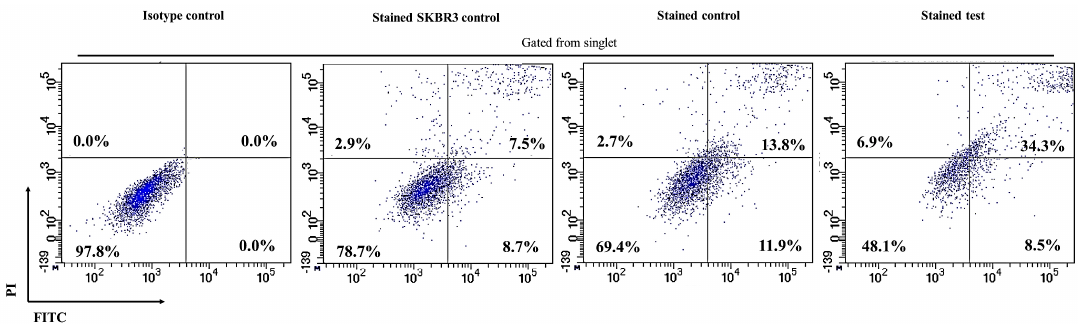
Figure 6. Detection of efficiency of CAR-T cells in SKBR3 cell lysis by FITC Annexin V Apoptosis Detection Kit. The FITC Annexin V Apoptosis Detection Kit was used to measure the amount of apoptosis seen in SKBR3 cells following co-culture with CAR-T cells (stained test) and non-transduced T-cells (stained control). SKBR3 single culture (stained SKBR3 control) was designated as the background. The cell population was gated at SKBR3 cells. Singlet was gated from the SKBR3 cells population to remove residual cell clumps following disaggregation and eliminate auto-fluorescence. Subsequently, apoptotic cells were gated from the singlet population. Viable cells in the apoptosis assay are stained FITC − /Propidium iodide − (PI), necrotic cells are stained FITC − /PI+, early apoptotic cells are stained FITC+/PI − , while late apoptotic cells are stained FITC+/PI+. Upon co-culture with CAR-T cells, SKBR3 cells showed increased late apoptotic cells and necrotic cells compared to non-transduced T-cells. Meanwhile, the number of viable SKBR3 cells decreased in co-culture with CAR-T compared to non-transduced T-cells. In comparison, stained SKBR3 control showed lower late apoptotic and necrotic cells. The data is a representative of one technical replicate from cells ( n = 6) that were pooled together prior to flow cytometric analysis.